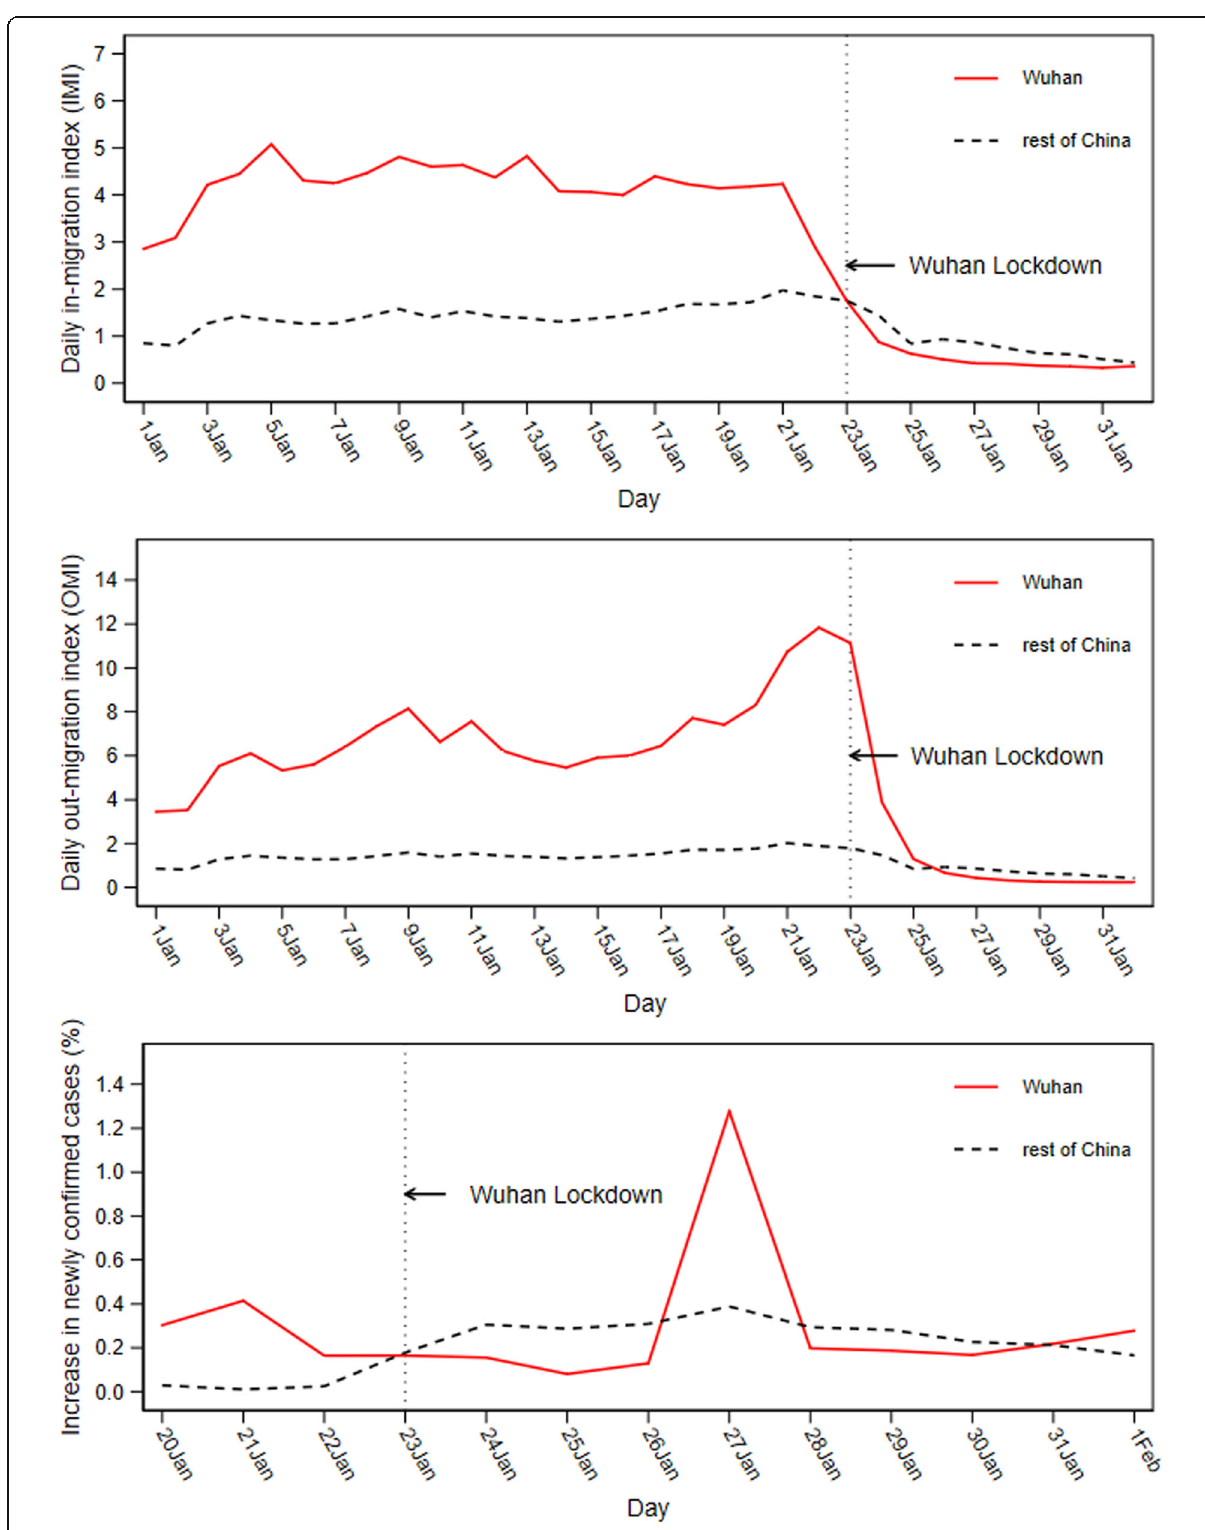
Fig. 1 Trends in IMI , OMI , and NewGrowth : Wuhan vs. other cities in China. Note: Since COVID-19 data for most cities were not available until January 20, our sampling period for the study of the growth rate of newly confirmed cases began on January